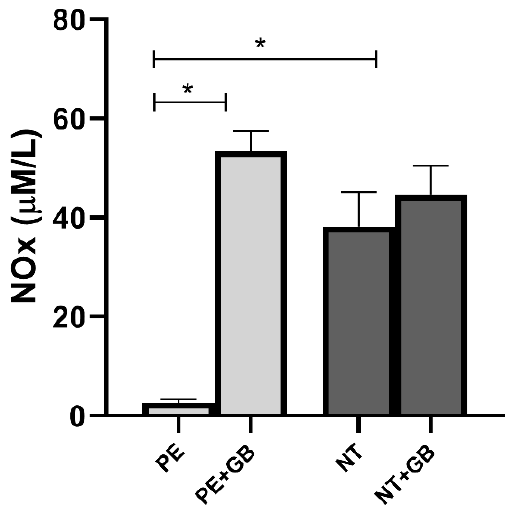
Figure 3. Nitrite + nitrate levels (Nox) in the cell supernatant of human umbilical vein endothelial cells (HUVEC) incubated for 24 h with 20% ( v / v ) plasma pool from NT and PE pregnant women and GB. Values are represented as means ± SEM. Comparisons between groups were assessed by One-Way ANOVA followed by Tukey’s Test. * ( p < 0.05).